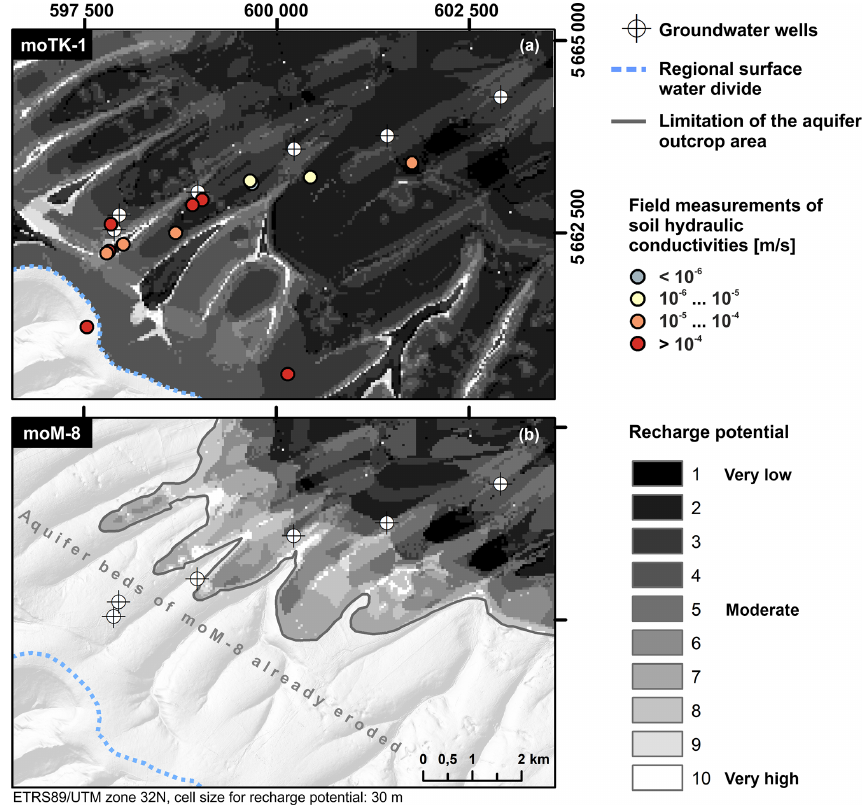
Figure 8. Recharge potential maps for the two contrasting aquifer storeys moTK-1 (a) and moM-8 (b) . The recharge potential is a qualitative indicator for infiltration and percolation towards selected aquifer storeys: the brighter the output colour, the higher the recharge potential. Aquifer outcrop zones show the highest recharge potentials followed by sinkhole lineaments and (NE–SW orientated) transverse valleys. The recharge potential decreases drastically with increasing thickness of overburden strata towards the NE. Data points of field measurements are displayed in the upper map (moTK-1 recharge potential) and are colour-coded with respect to their soil hydraulic conductivity. Data sources: DEM© GeoBasisDE/TLVermGeo, gen. no.: